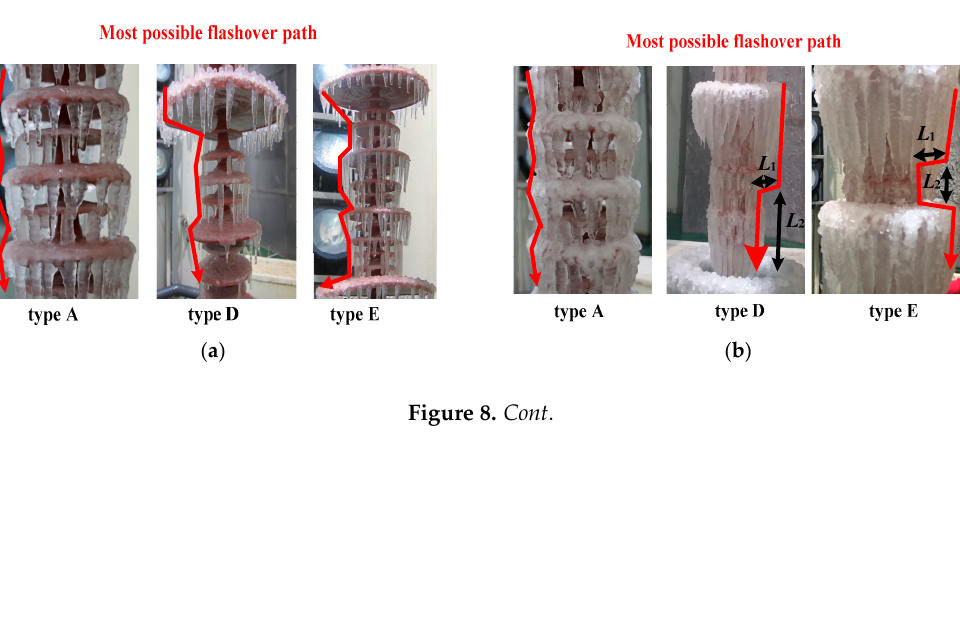
Figure 7. Flashover process of ice-covered insulators. ( a ) Type A; and ( b ) type C.